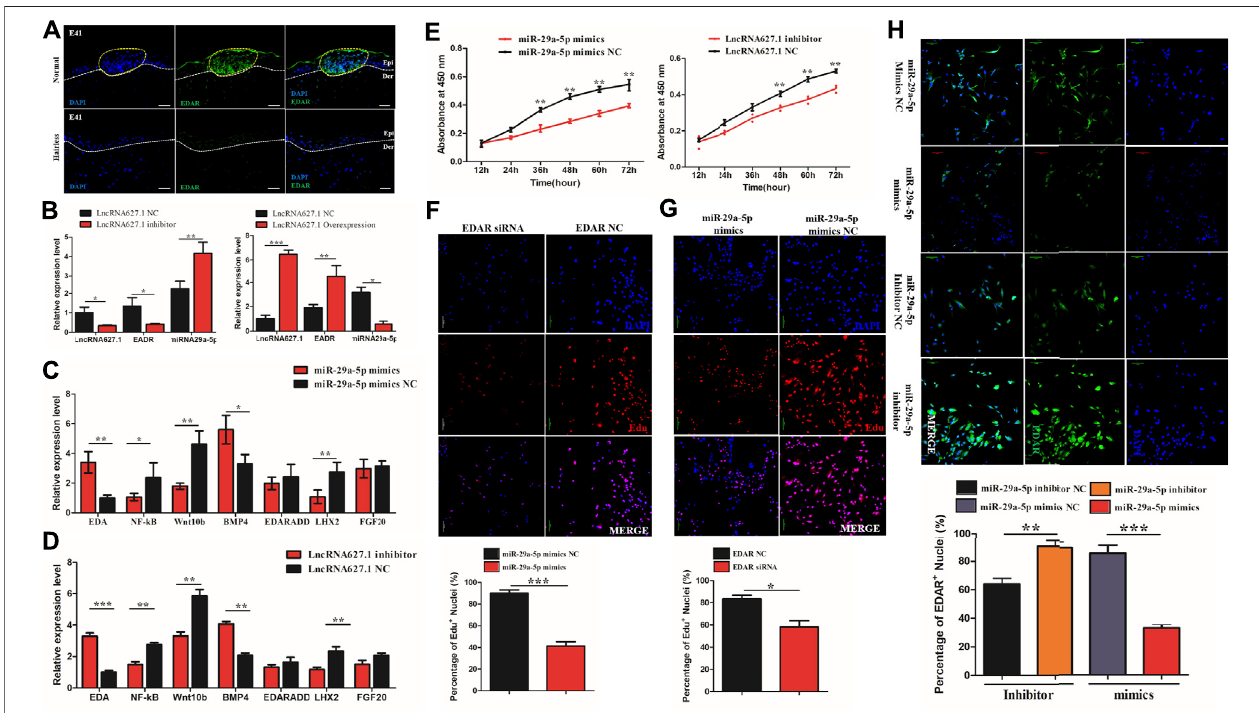
FIGURE4 | miRNA29a-5p regulates targeting ofEDAR by theWntsignaling pathway toinhibit hair placode formation. (A) Immuno fl uorescence (IF) ofEDAR in the hair placode during hair follicle morphogenesis in prenatal normal and hairless embryos. (B) The mRNA expression of EDAR and miR-29a-5p under lncRNA627.1 overexpression and the presence of an inhibitor. (C) The mRNA expression of related genes involved in the EDA/EDAR signaling pathway, following miR-29a-5p overexpression. (D) The mRNA expression of related genes involved in the EDA/EDAR signaling pathway following transfection with a lncRNA627.1 inhibitor. (E) Proliferation of fi broblasts at 0, 24, 36, 48, 60, and 72 h after transfection of miR-29a-5p mimics and a lncRNA627.1 inhibitor, as well as miR-29a-5p mimics NC and lncRNA627.1inhibitorNC. (F) Proliferating fi broblastslabeledwithEduaftertransfectingEDARsiRNA; (G) Proliferating fi broblastslabeledwithEdufollowingtransfection with miR-29a-5p mimics. The click-iT reaction revealed Edu staining (red). Cell nuclei were stained with DAPI (blue). (H) Protein expression of EDAR in fi broblasts following transfection of miR-29a-5p mimics, a miR-29a-5p inhibitor, miR-29a-5p mimics NC and lncRNA627.1 inhibitor NC, cell nuclei were stained with DAPI (blue) while EDAR proteins were stained green. ** p < 0.05, ** p < 0.01, *** p < 0.001.